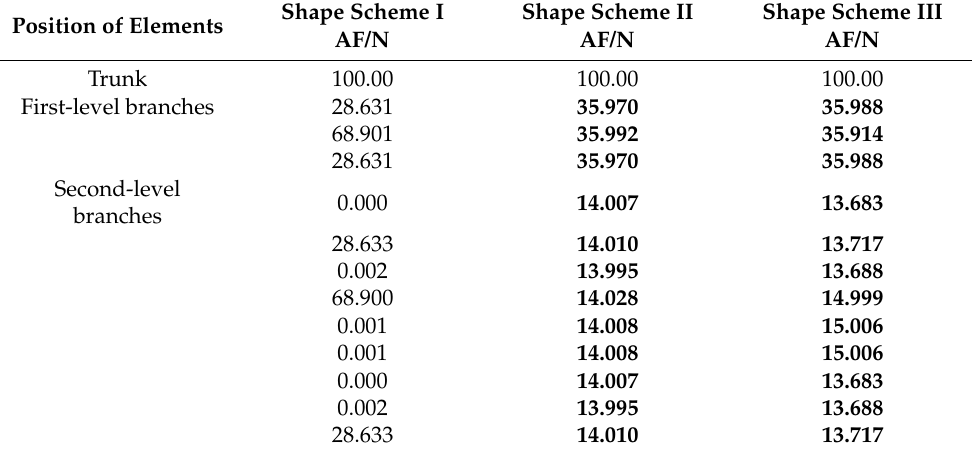
Table 1. Axial force of each element of the model in equilibrium